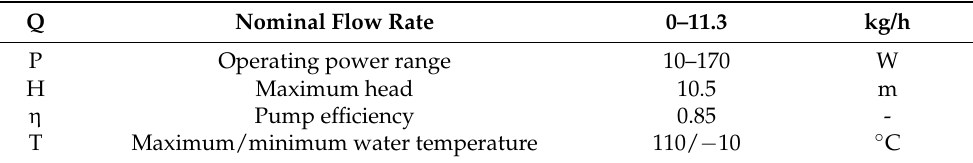
Table 5. Water pump specification